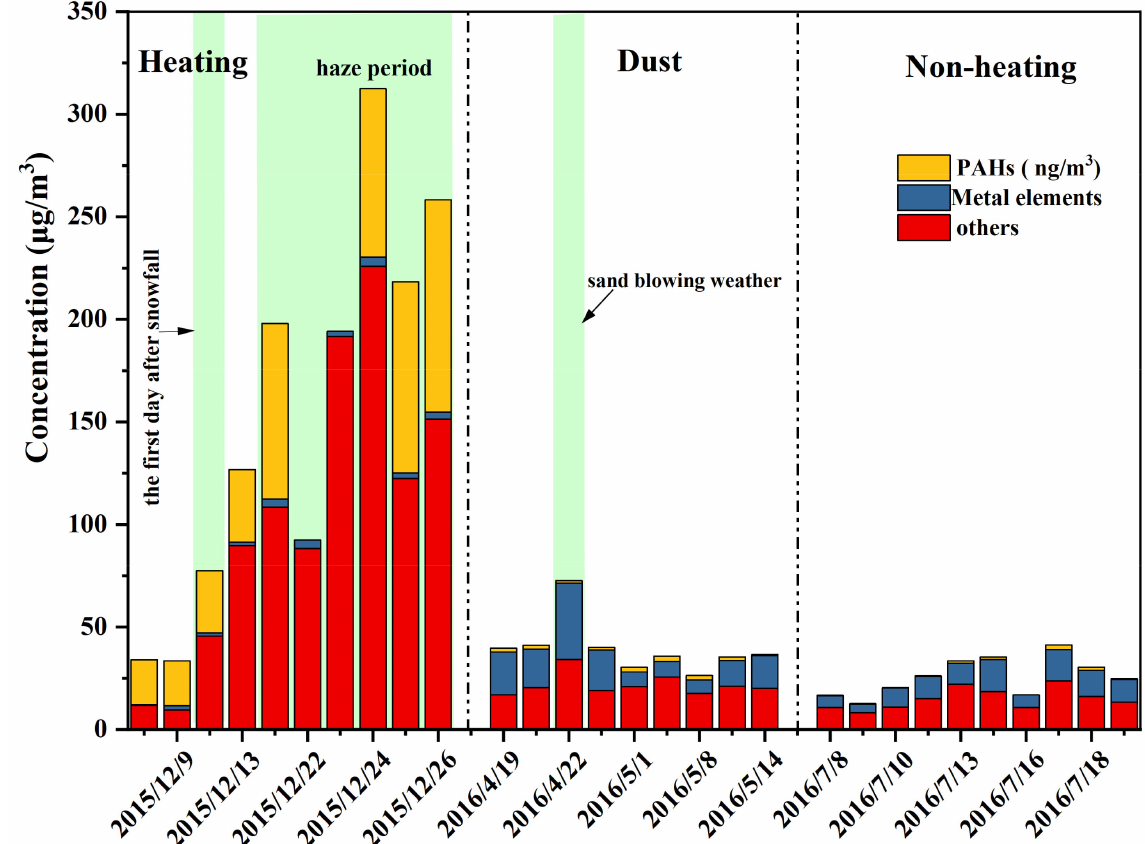
Figure 6. Concentrations of the components of PM 2.5 under special weather